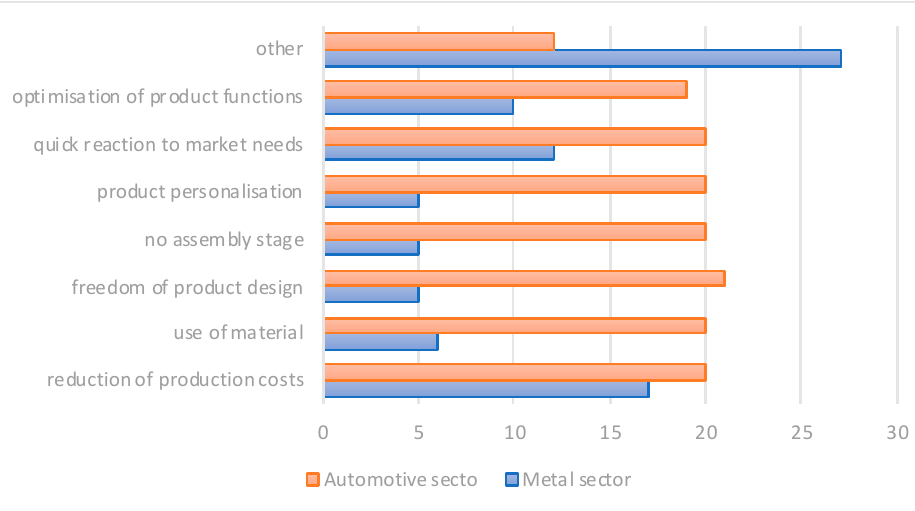
Figure 4. Factors affecting interest in implementing AM in the manufacturing companies surveyed in Figure 4. Factors a ff ecting interest in implementing AM in the manufacturing companies surveyed in the metal and automotive industries. the metal and automotive